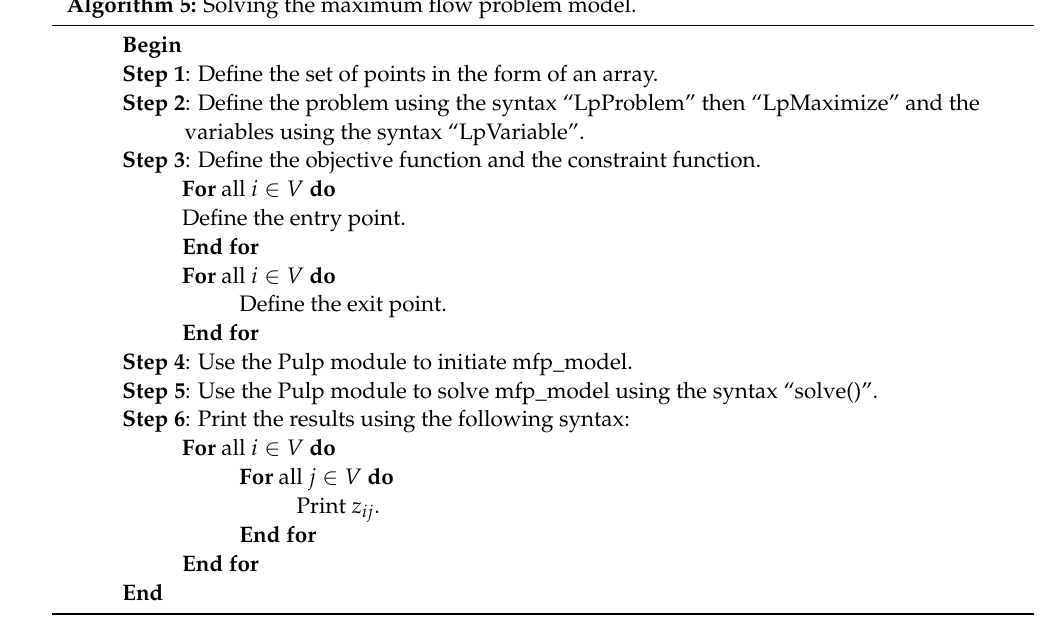
Algorithm 5: Solving the maximum flow problem